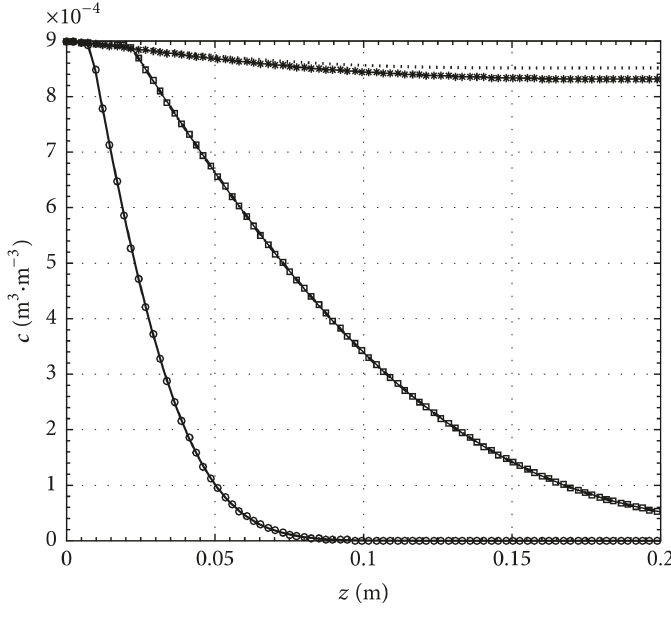
Figure 4. Nanoparticle concentration versus core length with and without the magnetic field effect for various values of imbibition time. The magnet is placed on the left side of the core